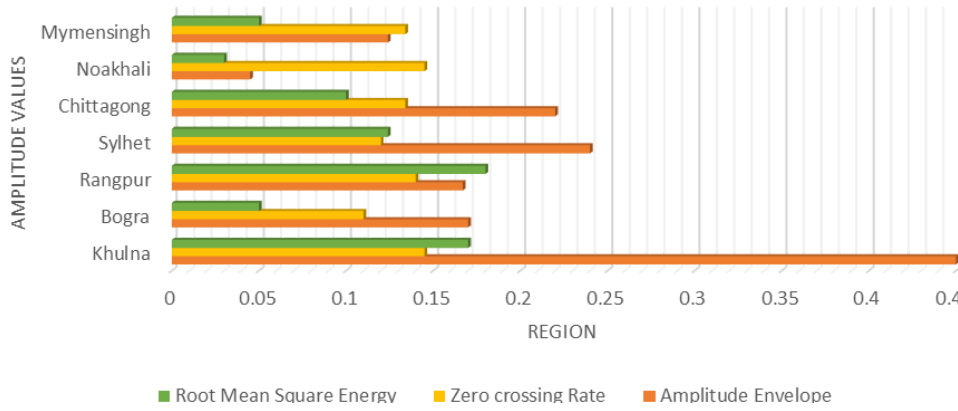
Figure 4. Distribution of audio features; spectral centroid and spectral bandwidth across the seven regional languages studied in this